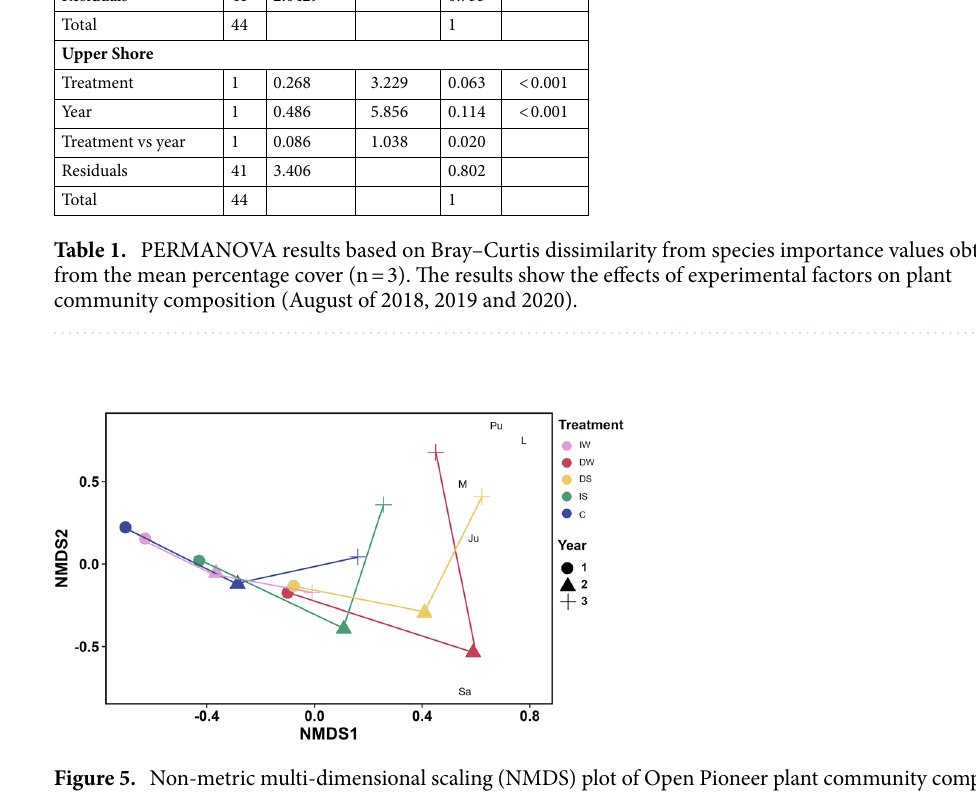
Figure 5. Non-metric multi-dimensional scaling (NMDS) plot of Open Pioneer plant community composition (averaged % cover from August; n = 3) based on Bray–Curtis dissimilarity matrix. Ju Juncus gerardii ,